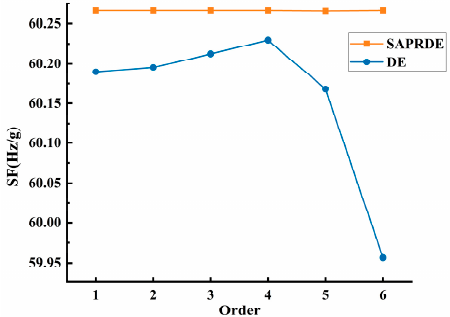
Figure 5. Convergence value at 400 generations of 6 random evolutions.